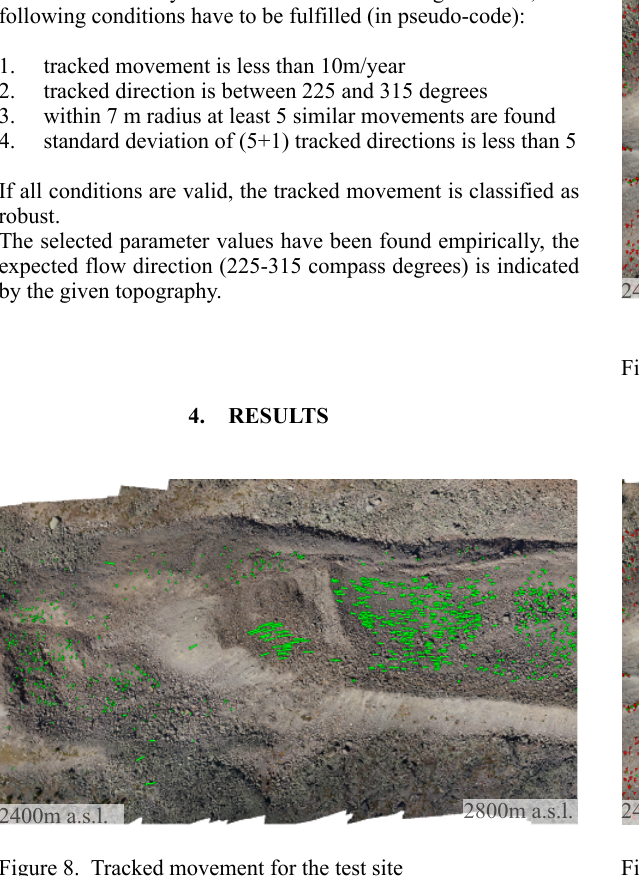
Figure 8. Tracked movement for the test site green: 2016-2017